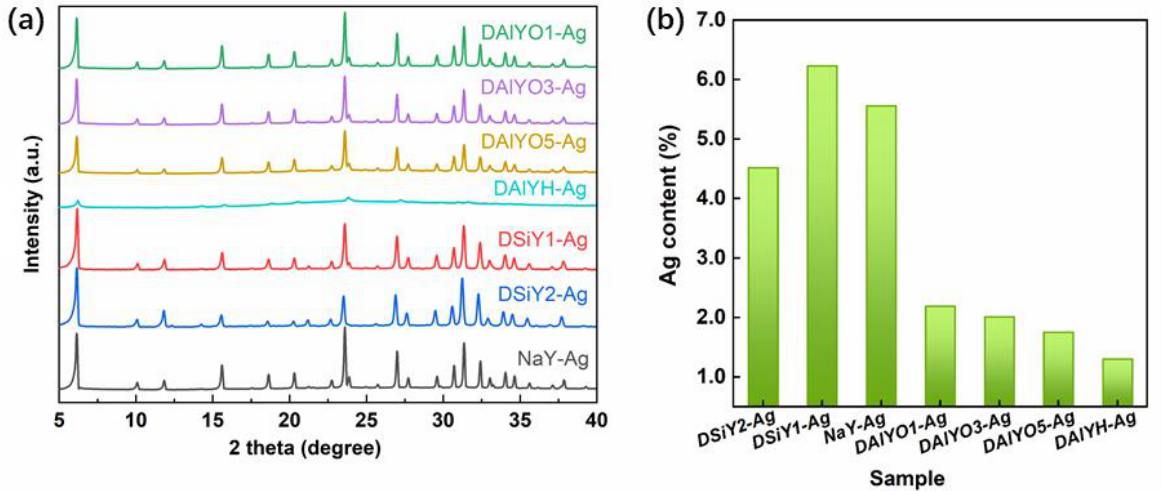
Figure 3. XRD patterns of NaY-Ag, DSiY1-Ag, DSiY2-Ag, DAlYO1-Ag, DAlYO3-Ag, DAlYO5-Ag and DAlYH-Ag ( a ); Ag atomic content from XPS measurement ( b ).